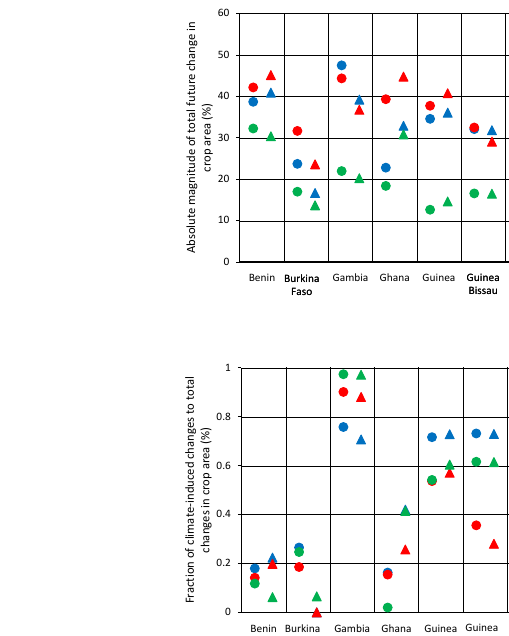
is most sensitive to the demand input and the order of land selection for agricultural